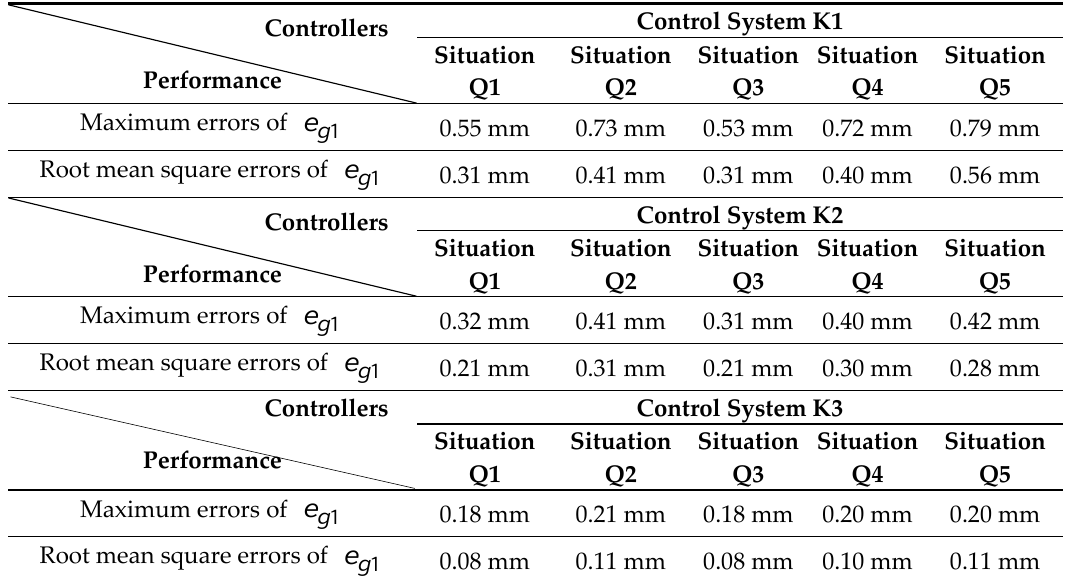
Table 2. Feature performance comparisons of control systems.